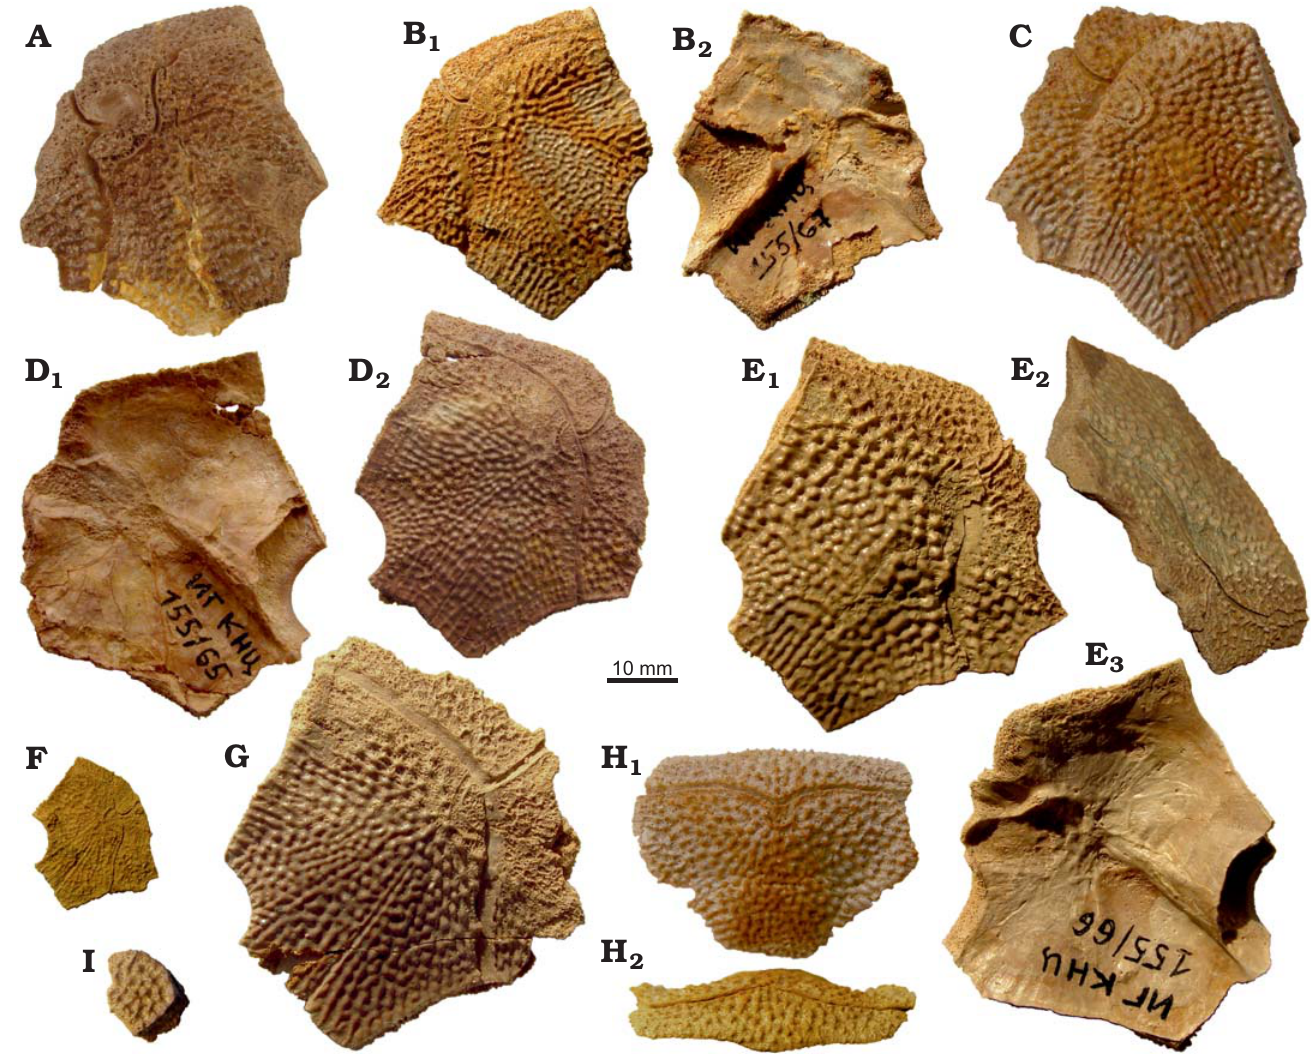
Fig. 4. Antiarchan fish Bothriolepis leptocheira jeremejevi (Rohon, 1900), Sosnogorsk locality, Sosnogorsk Formation, lowermost Famennian, lateral (A–G), premedian (H), and left postmarginal (I) plates of the head shield. A . IG KSC 155/15 in dorsal view. B . IG KSC 155/67 in dorsal (B 1 ) and visceral (B 2 ) views. C . IG KSC 155/129 in dorsal view. D . IG KSC 155/65 in visceral (D 1 ) and dorsal (D 2 ) views. E . IG KSC 155/66 in dorsal (E 1 ), right lateral (E 2 ), and visceral (E 3 ) views. F . IG KSC 155/69 in dorsal view. G . IG KSC 155/64 in dorsal view. H . IG KSC 155/114 in dorsal (H 1 ) and anterior (H 2 ) views. I . Plate disconnected from the partial head shield IG KSC 155/161, in dorsal